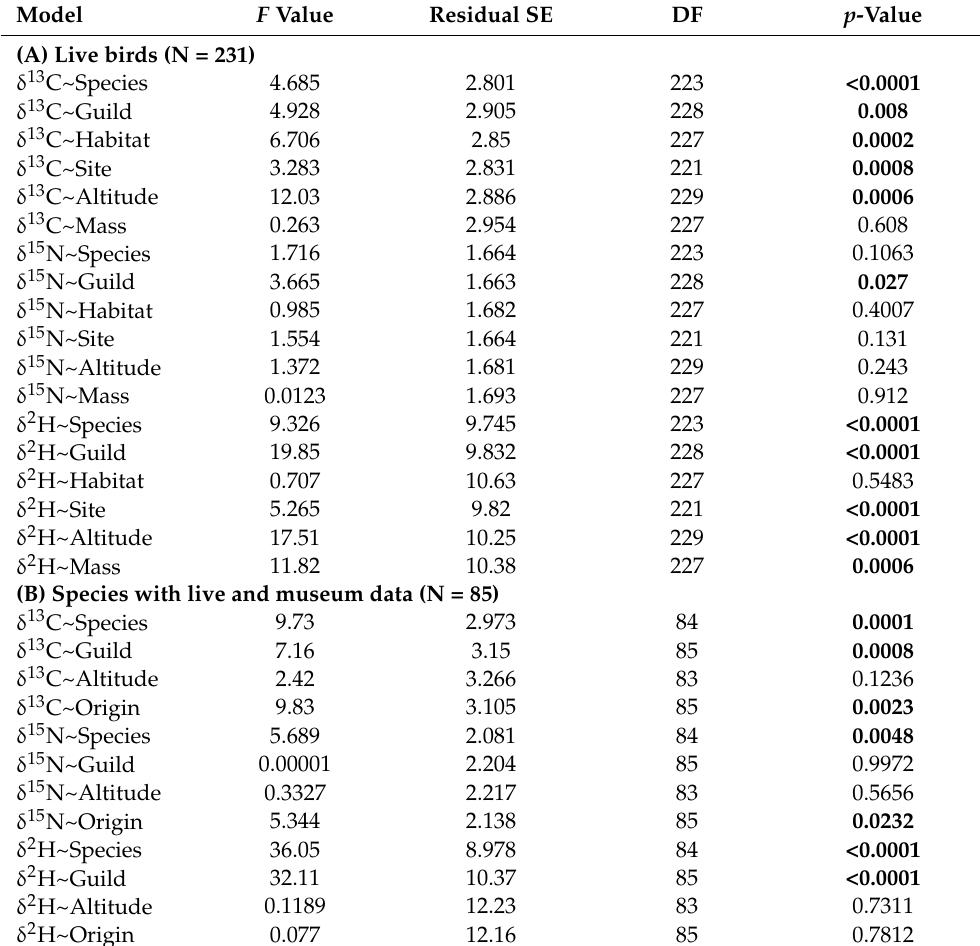
Table 3. Simple linear relationships between feather δ 13 C, δ 15 N and δ 2 H values and each of the explanatory variables, for each dataset analyzed: (A) Live birds (N = 231), and (B) Species with live and museum data (N = 85). Significant models are in bold.